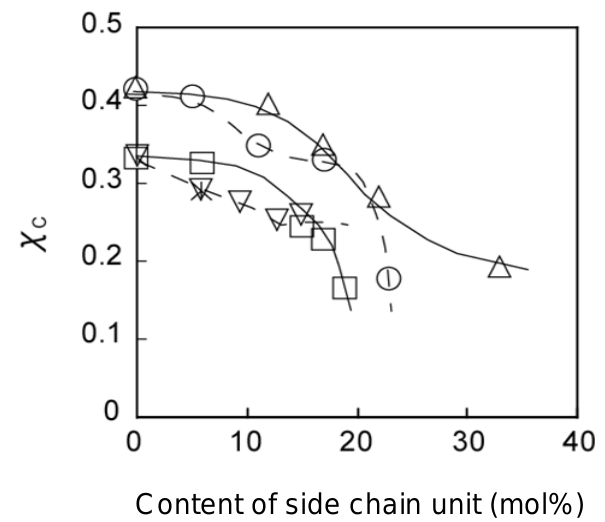
Figure 2. The degree of crystallinity ( χ and PHS/M-16 ( ▽ ) with various monomer contents.